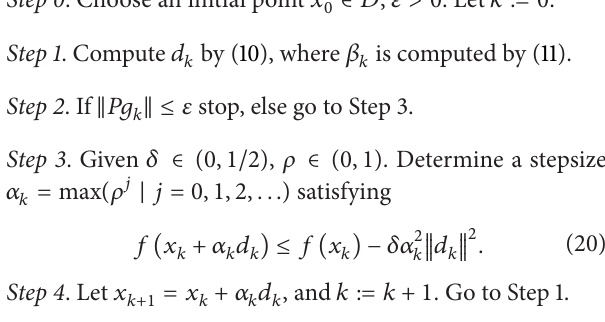
Algorithm 2 (EMPRP method with Armijio-type line